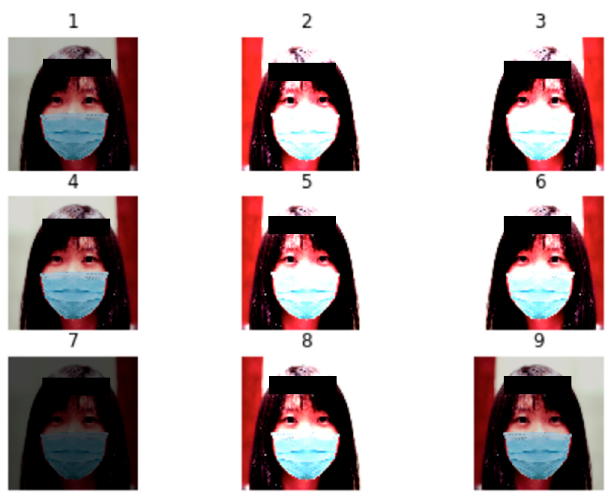
Figure 2. Sample Augmented Images.